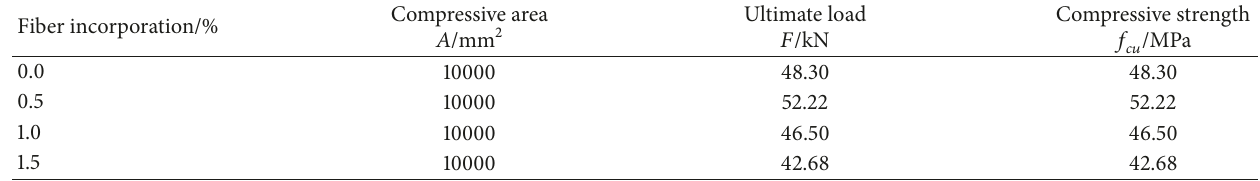
Table 4: Test data of the axial compressive strength of fiber reinforced